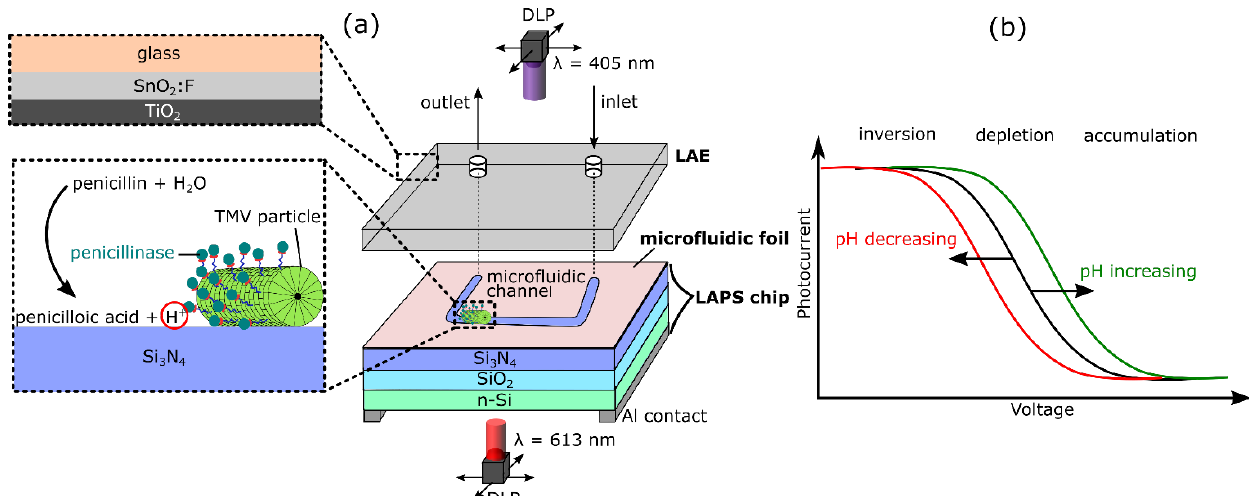
Figure 1. ( a ) Schematic of the microfluidic setup with a light-addressable potentiometric sensor (LAPS)/microfluidic foil/ light-addressable electrode (LAE)-sandwich structure. Tobacco mosaic virus (TMV) particles functionalized with the enzyme penicillinase are immobilized inside the microchannel. ( b ) Typical shape of a photocurrent-voltage curve for a n-type LAPS with characteristic regions of inversion, depletion and accumulation.